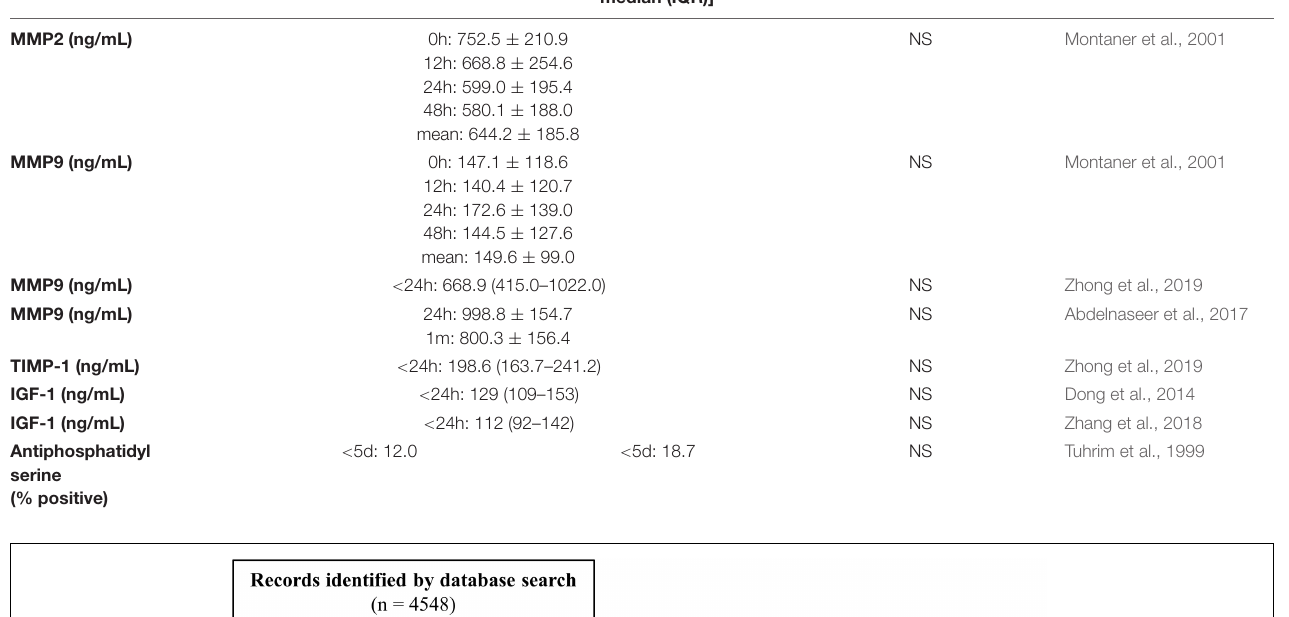
TABLE 4 | Other factors involved in hemostasis.